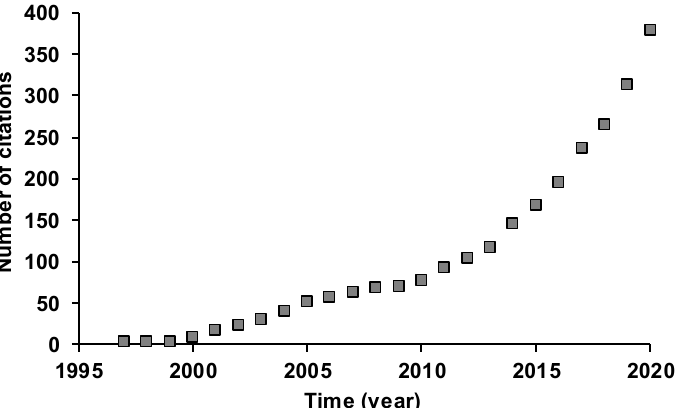
Figure 1. Cumulative number of citations of works reporting on the chemical composition of essential oils of Pinus brutia tree parts and derived bioproducts, obtained from Web of Science (https://www.webofknowledge.com, accessed 29 March 2021), using the keywords “ Pinus ”, “ brutia ” and “essential oil”.